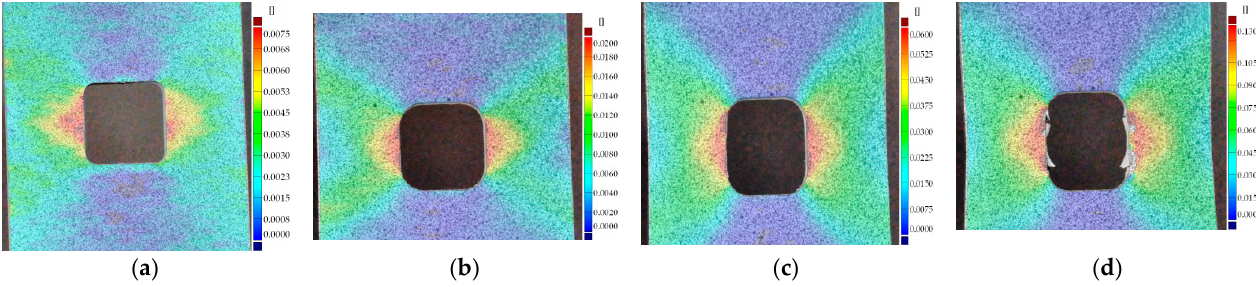
Figure 12. Distribution of strains on the surface for sample no. 4 with rectangular holes with a fillet radius R4 for strain: ( a ) ε TOT = 0.35%; ( b ) ε TOT = 0.40%; ( c ) ε TOT = 0.85%; ( d ) ε TOT = 1.63%.